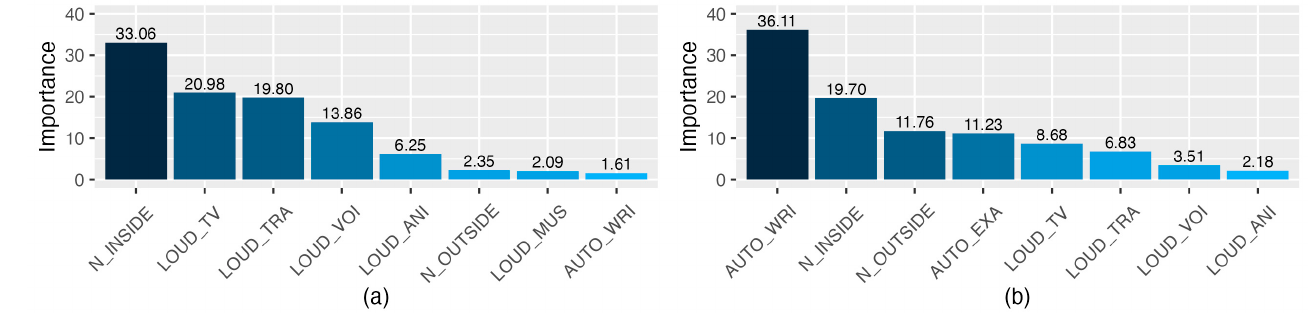
Figure 9. Percentage of the relative importance of the predictors of the ANNs on the noise interference with the autonomous activities calculated with the Olden et al. method [61], using as predictors the variables selected by mRMR ( b ) and the set of reduced Boruta variables ( a ). Values higher than zero mean a positive relative contribution, and those lower than zero mean a negative relative contribution.